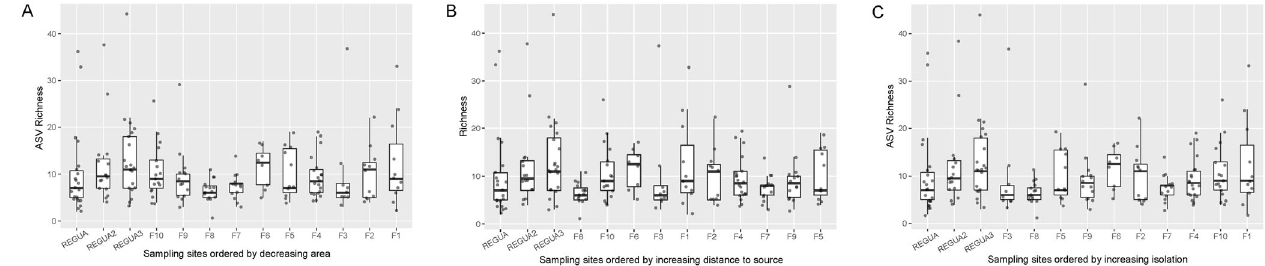
Fig. 3 Taxon richness by site. Box and whisker plot of the bacterial ASV richness in each sampling site in order of decreasing area ( A ), increasing distance from a source ( B ), and increasing isolation ( C